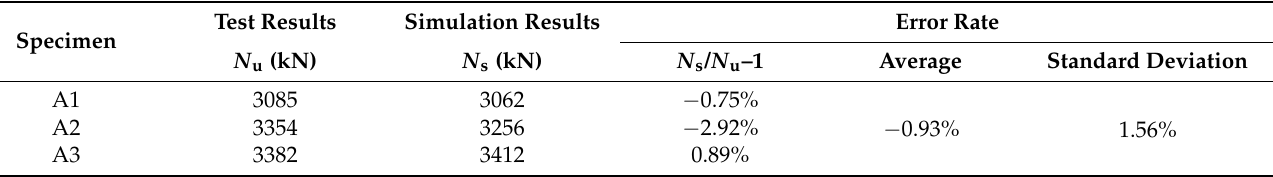
Table 5. Comparing the simulation data with the test results.